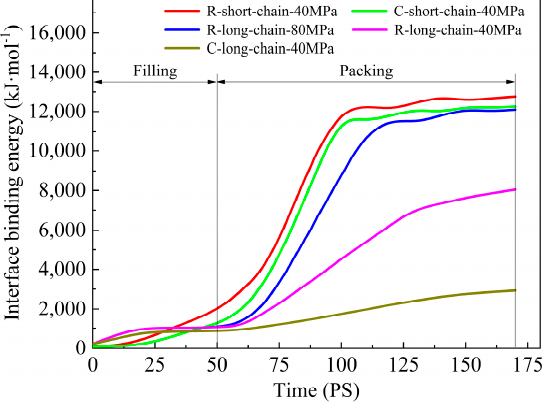
Figure 5. The change curve of interface binding energy with time.